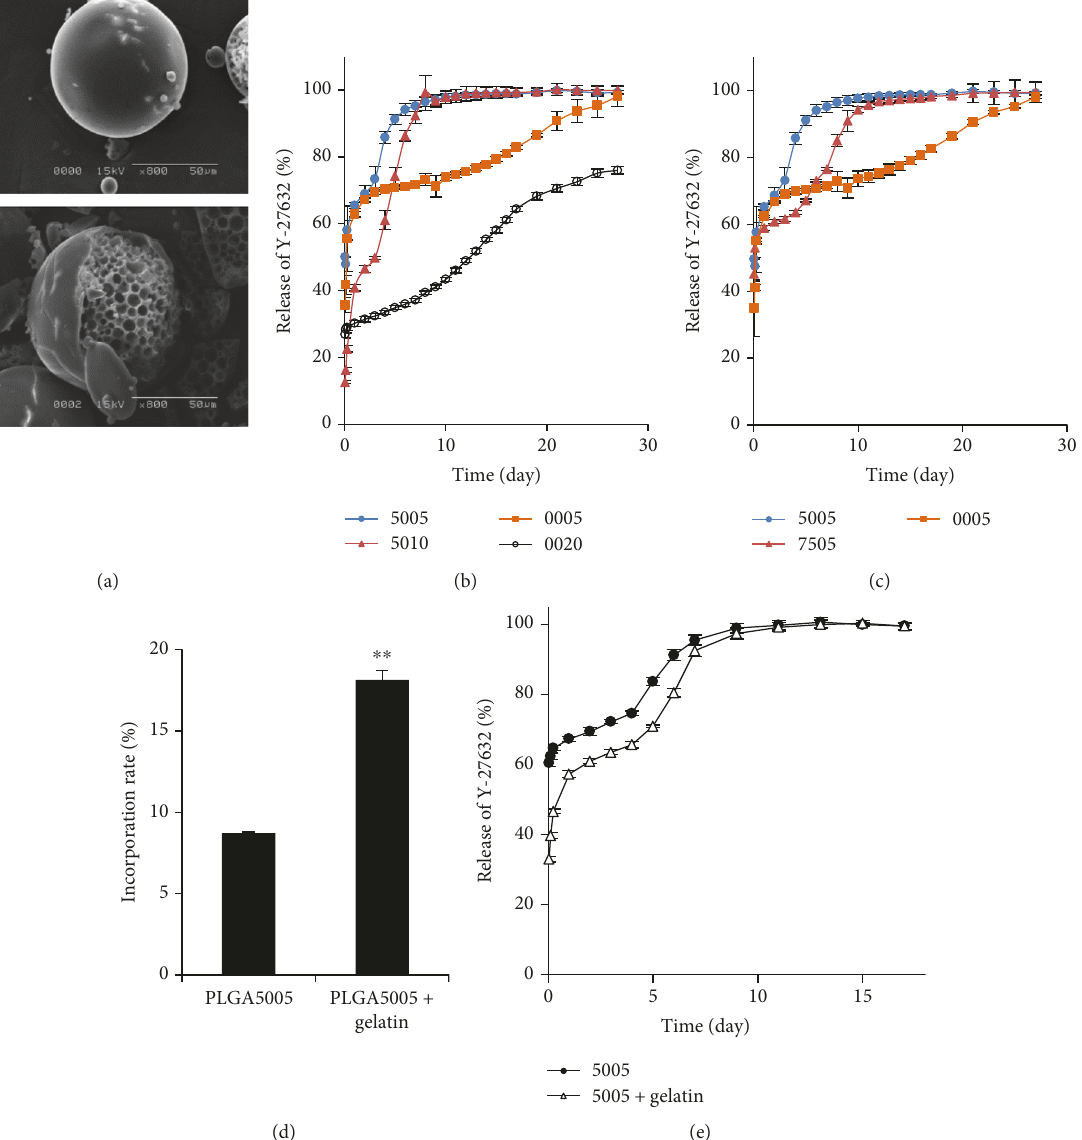
Figure 1: Characteristics of poly lactic/glycolic acid (PLGA) or poly lactic acid (PLA) microspheres for Y-27632 release. (a) PLGA microspheres were examined with a scanning electron microscope. The upper panel shows the surface of the microsphere, and the lower panel shows the internal structure of the microsphere. (b) PLGA or PLA microspheres were incubated in a PBS at 37 ° C for 14 days, and the amount of Y-27632 released was determined by HPLC. The e ff ect of the molecular weight on the release pro fi le for PLGA or PLA microspheres was evaluated. The cumulative amount of released Y-27632 was plotted in the graph ( n = 3 ). (c) PLGA or PLA microspheres were incubated in PBS at 37 ° C, and the amount of Y-27632 released was determined by HPLC. The e ff ect of the composition of lactic acid and glycolic acid on the release pro fi le was evaluated ( n = 3 ). The PLGA5005 release curve plotted is the same as that shown in Figure 1(b). (d) Y-27632 was dissolved in ultrapure water with or without gelatin, and PLGA5005 microspheres were prepared ( n = 3 ). The incorporation rate was evaluated by HPLC. ∗∗ p < 0 01 . (e) PLGA5005 with or without gelatin that incorporated Y-27632 was incubated at PBS at 37 ° C for 14 days, and the amount of Y-27632 released was determined by HPLC. Three independent experiments were